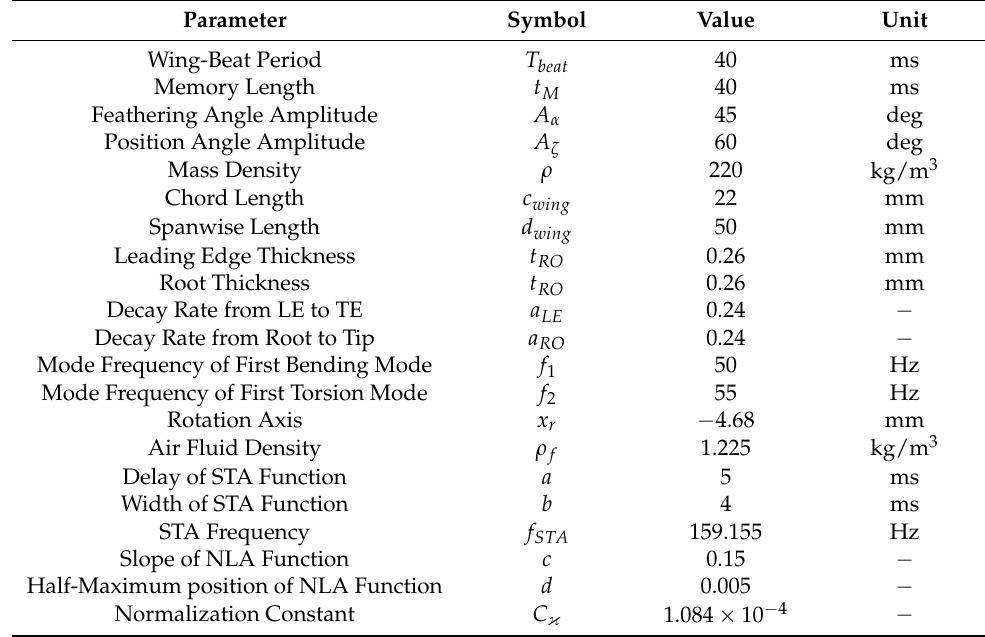
Table 3. Detailed parameters used in the simulation. Parameter